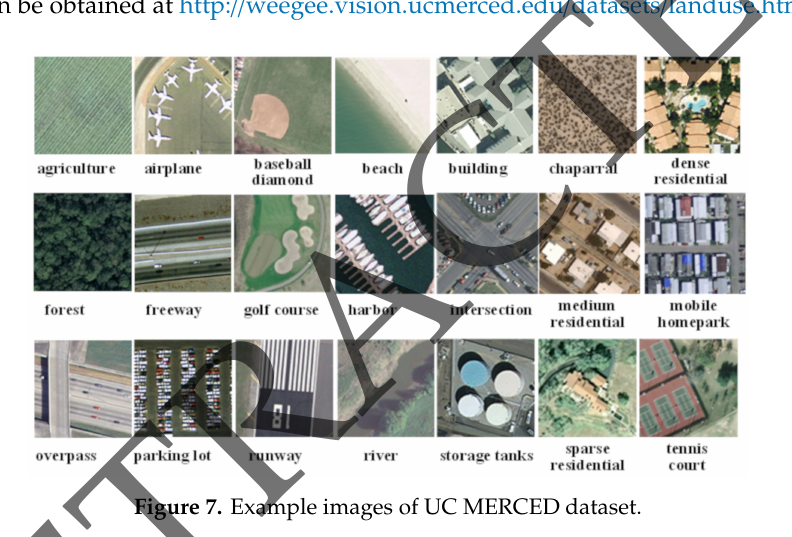
Figure 7. Example images of UC MERCED